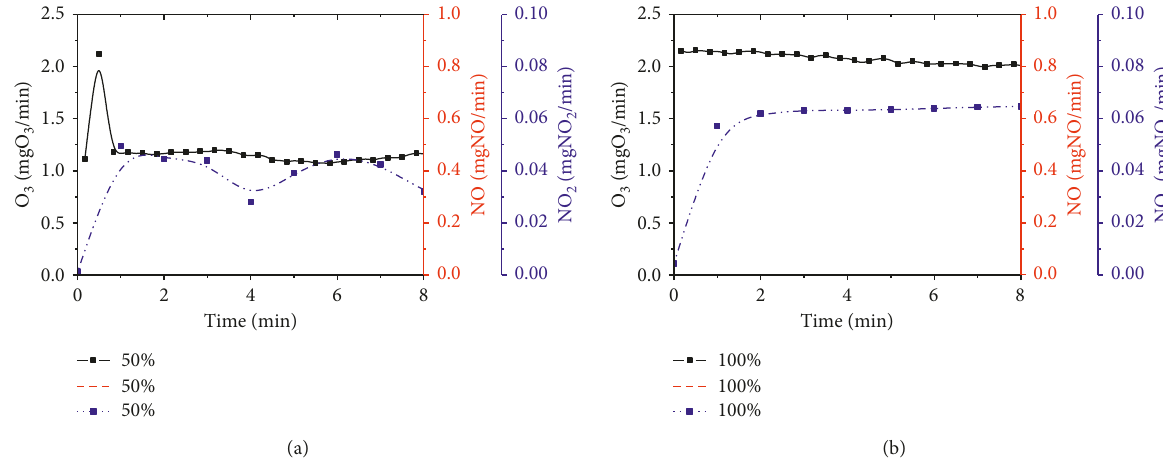
Figure 2: Active species generation amount of corona discharge air plasma. Table 1: Measurement of active species generated by corona discharge air